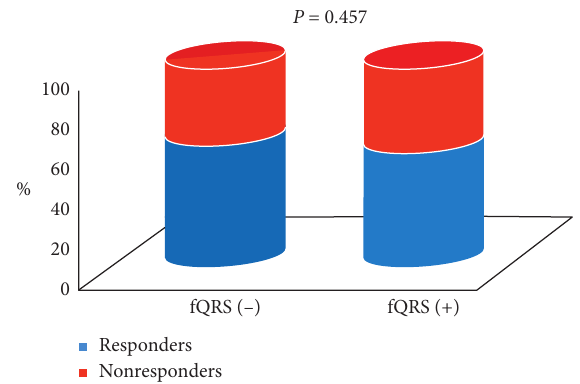
Figure 3: Distribution of responders and nonresponders according to the presence of fragmentation of the QRS